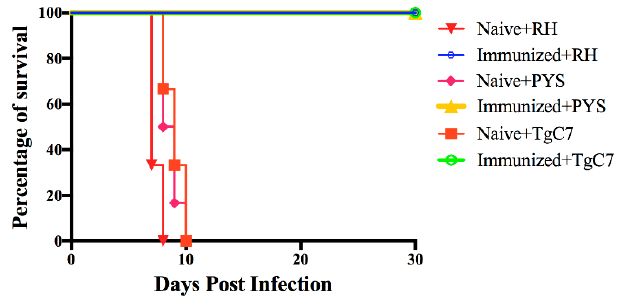
Figure 6. Survival curves of vaccinated and infected mice. At 60 days post-vaccination, mice were i.p. challenged with 10 3 T. gondii tachyzoites of RH, PYS, or TgC7 strains (6 mice/strain), and monitored for 30 days. Survival curves of RH ∆ gra17 ∆ npt1 -vaccinated mice showed a high survival rate compared to naïve mice.